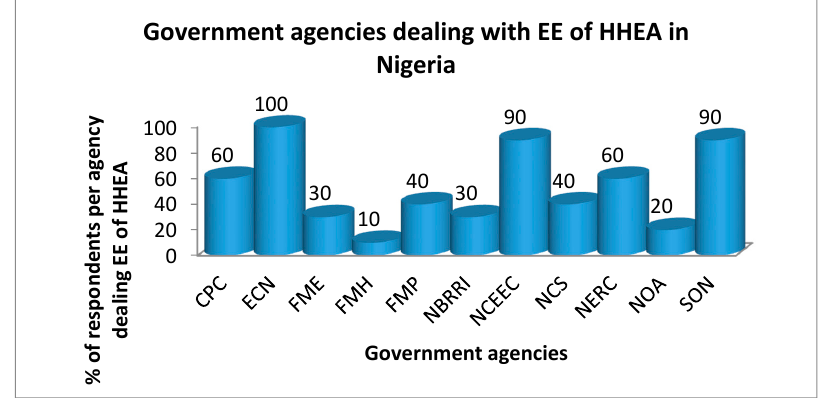
Figure 6. Government agencies dealing with energy efficiency (EE) of household electrical appliances (HHEA) in Nigeria (in percentage of experts interviewed agreeing with statements that particular government agencies were, in fact, involved in actions targeting energy efficient household electrical appliances adoption by households).